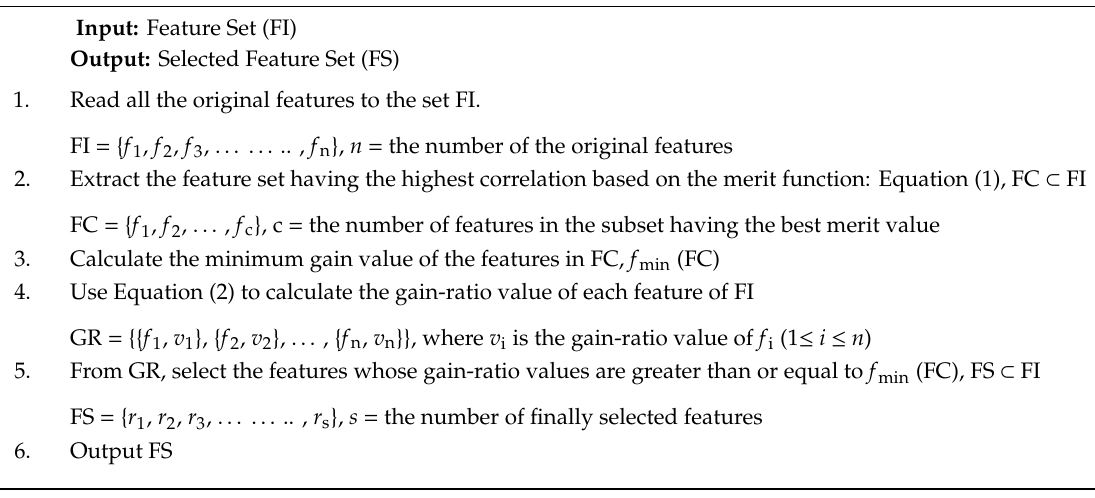
Algorithm 1 Correlated-Set Thresholding on Gain-Ratio